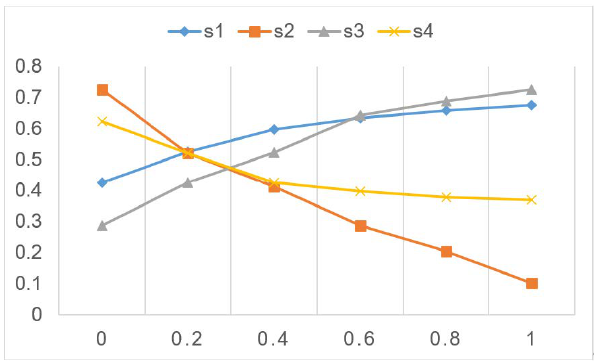
Fig. 3 The influence β on the order of the